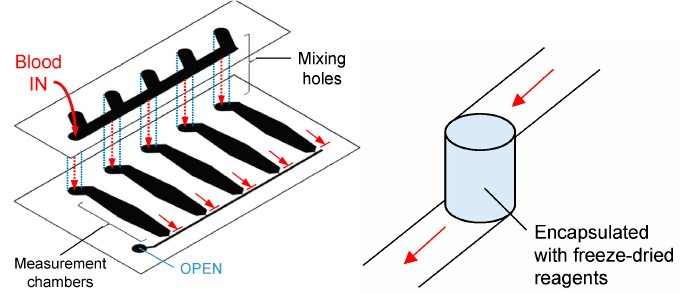
Figure 5. Mixing-hole micro-channels, taken from Reference [67]. For the mixing hole channel, the samples that flow from the upper channel mix with the freeze-dried reagent in the mixing hole and subsequently flow to the lower channel. The device is used to detect hemagglutination.